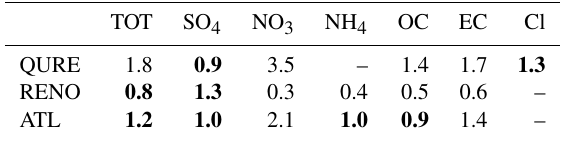
Table 2. The ratio of mean magnitude of the trend component r trend (CMAQ/observation). Boldface values indicate a relatively good es- timate of the magnitude